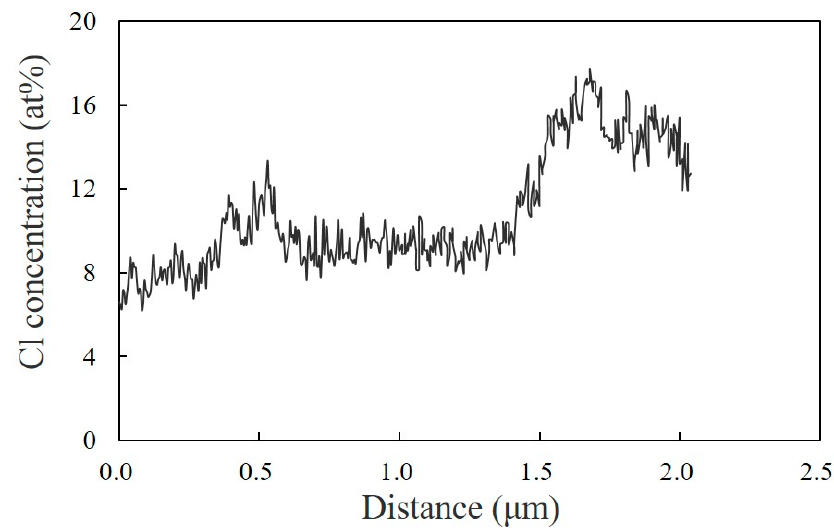
Figure 7. Concentration distribution in chlorine of PVC for the melt-mixed 60/40 NBR/PVC in the region indicated by a red line in Figure 6a.